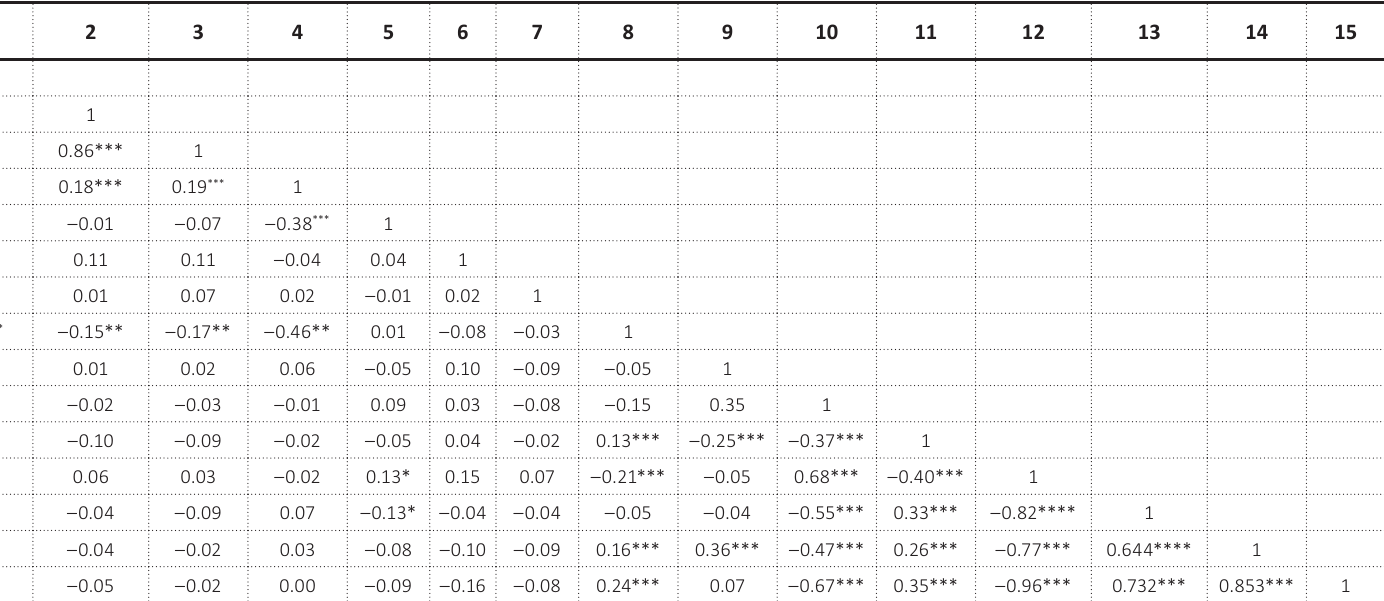
Table 3. Correlation matrices of